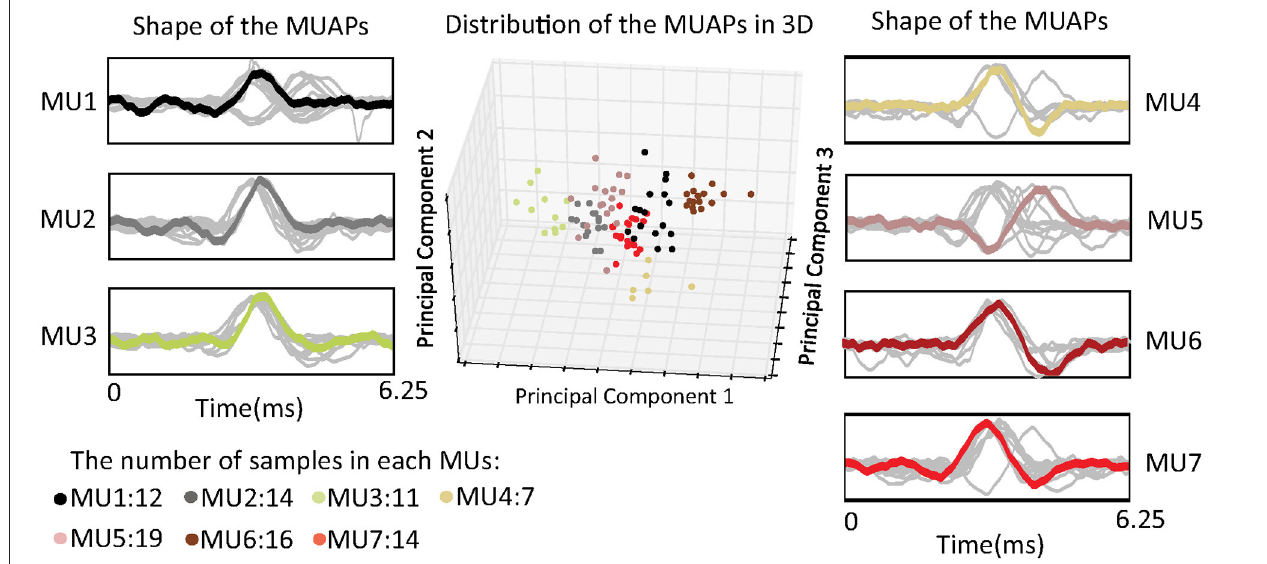
FIGURE 4 | Distribution of the shape of the MUAPs in three dimensions using principal component analysis.